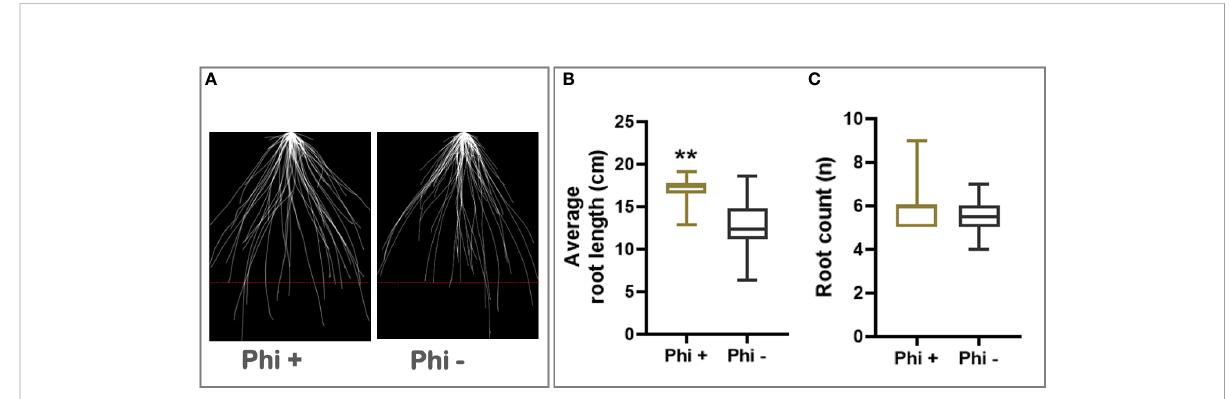
FIGURE 1 Phosphite promotes root growth in wheat seedling. (A) Superimposed 2D root images of young seedlings grown in low strength hydroponic media showing improvement in seminal and nodal root length at 7 days post phosphite treatment. (B) Seminal root length (C) seminal root count. All values are means ± SE (n= 25); ** indicates signifcant difference (P ≤